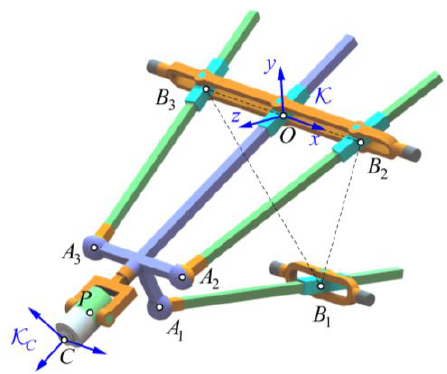
Figure 2. Schematic diagram of the TriMule robot.